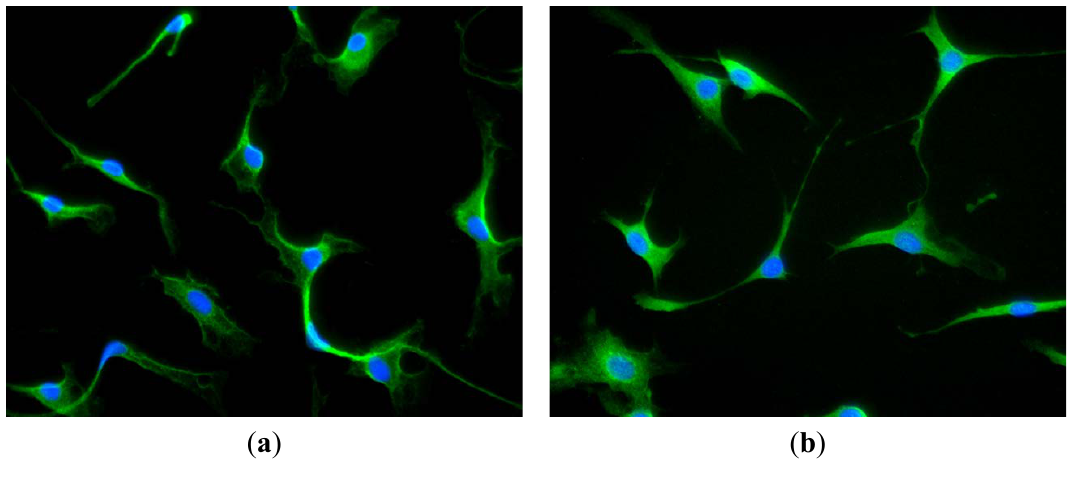
Figure 1. MT2 receptor expression in growth plate chondrocytes (GPCs) from adolescent idiopathic scoliosis (AIS) patients and control subjects. Immunofluorescent staining was carried out using purified rabbit polyclonal anti-MT2 antibodies. MT2 receptor was demonstrated in GPCs from AIS patients ( a ) and control ( b ) subjects; The immunoreactivity was observed mainly in the cytoplasm. No staining was observed in the negative control ( c ); The mRNA expression of MT2 receptor was quantified by qRT-PCR. The GPCs from AIS patients showed a significantly lower expression than those of control subjects ( d ) (Students’ t test, * p <